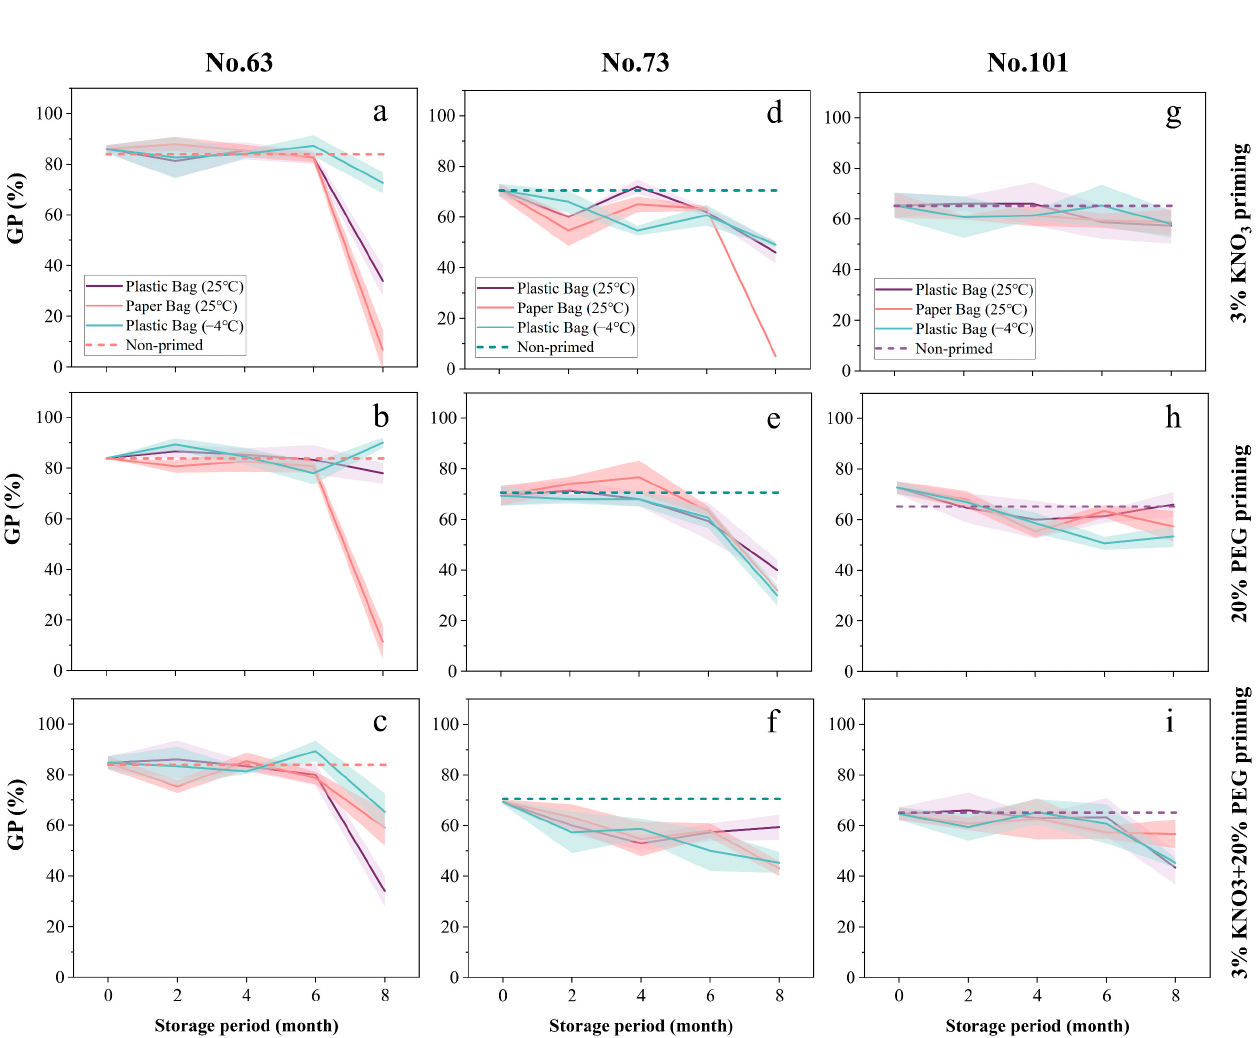
Figure 4. The final germination percentage of primed pepper seeds in different storage conditions over time. GP: germination percentage. ( a – c ) the germination percentages for No.63 pepper seeds; ( d – f ) the germination percentages for No.73 pepper seeds; ( g – i ) the germination percentages for No.101 pepper seeds. ( a , d , g ) 3% KNO 3 priming; ( b , e , h ) 20% PEG priming; ( c , f , i ) 3% KNO 3 + 20% PEG priming. The light-shaded area around the curve represents the standard error.